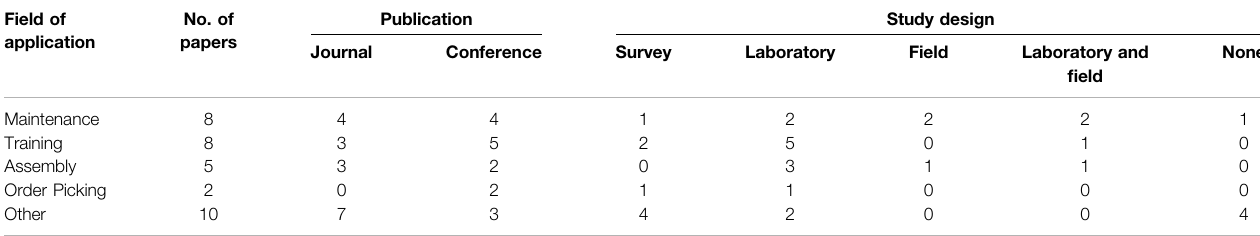
TABLE 3 | Categorization and study design of the identi fi ed